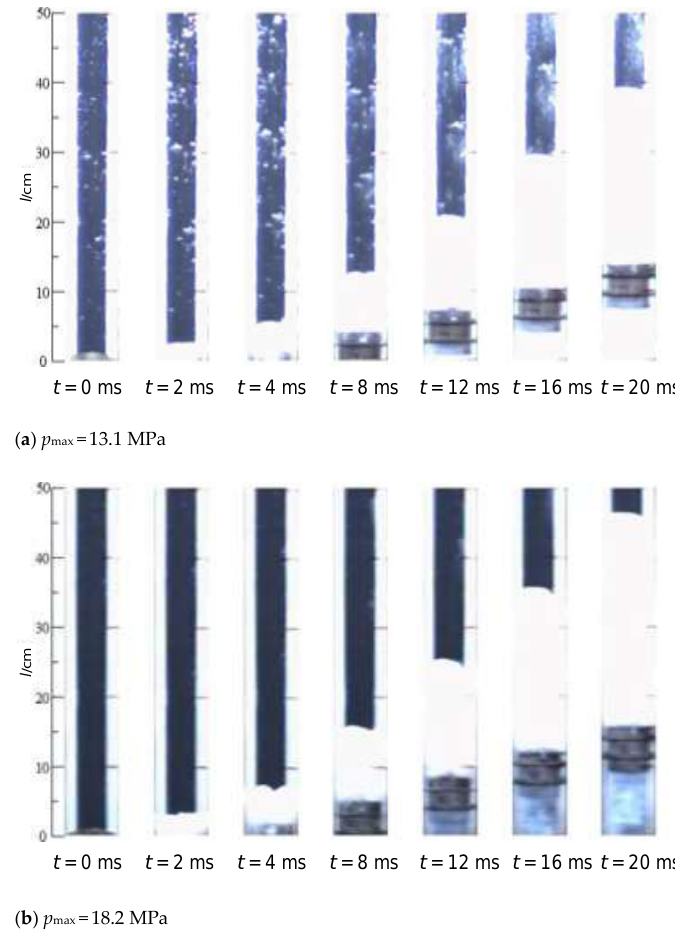
Figure 6. Sequence diagram of simulated launching process under different maximum pressures (Projectile B, n = 4).